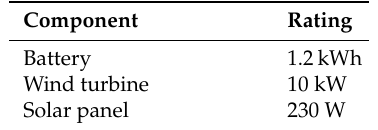
Table 2. Power rating of system model components.